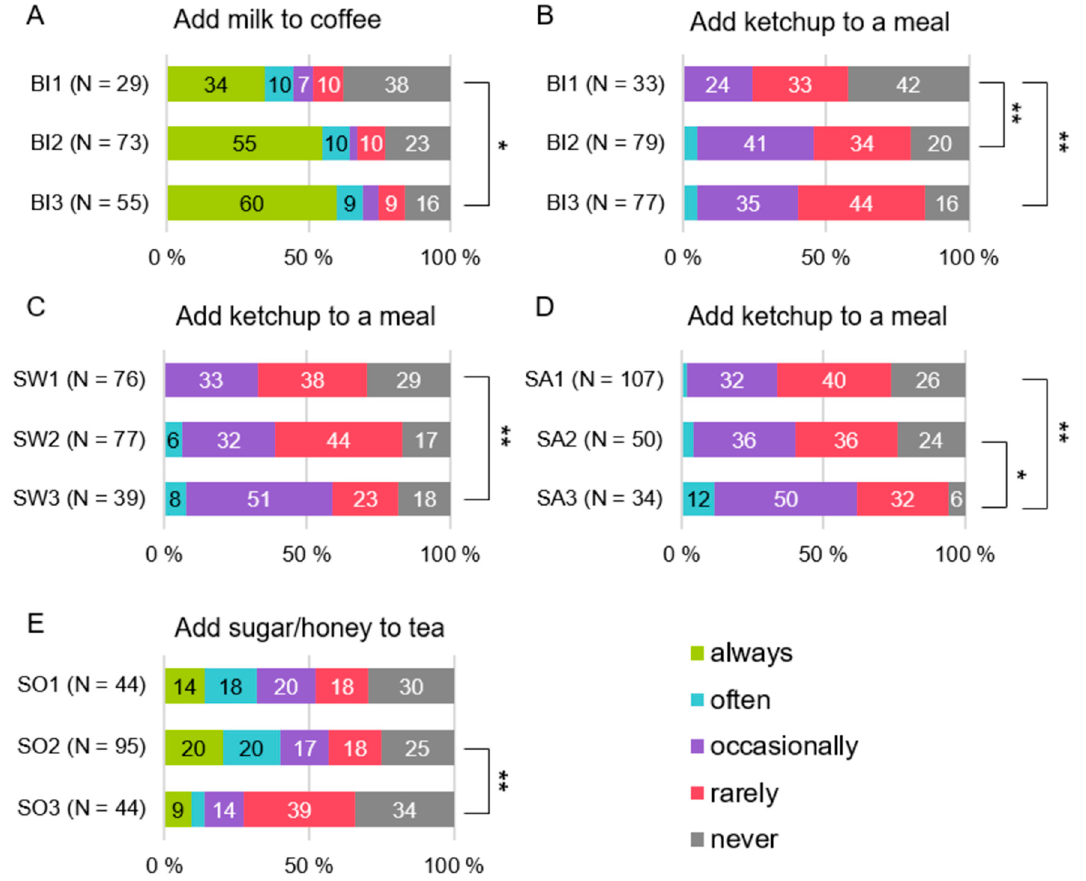
Figure 3. Differences in the frequency to mask/modify tastes by taste sensitivity groups, 1 = the least sensitive subjects, 2 = semi-sensitive subjects, 3 = the most sensitive subjects. ( A ) bitter sensitivity vs. the habit of adding milk to coffee, ( B ) bitter sensitivity vs. adding ketchup to a meal when eating it, ( C ) sweet sensitivity vs. adding ketchup to a meal when eating it, ( D ) salty sensitivity vs. adding ketchup to a meal when eating it, ( E ) sour sensitivity vs. habit of adding sugar/honey to tea. BI—bitter; SW—sweet; SA—salty; SO—sour. * p < 0.05, **p < 0.01 based on Mann-Whitney U tests.